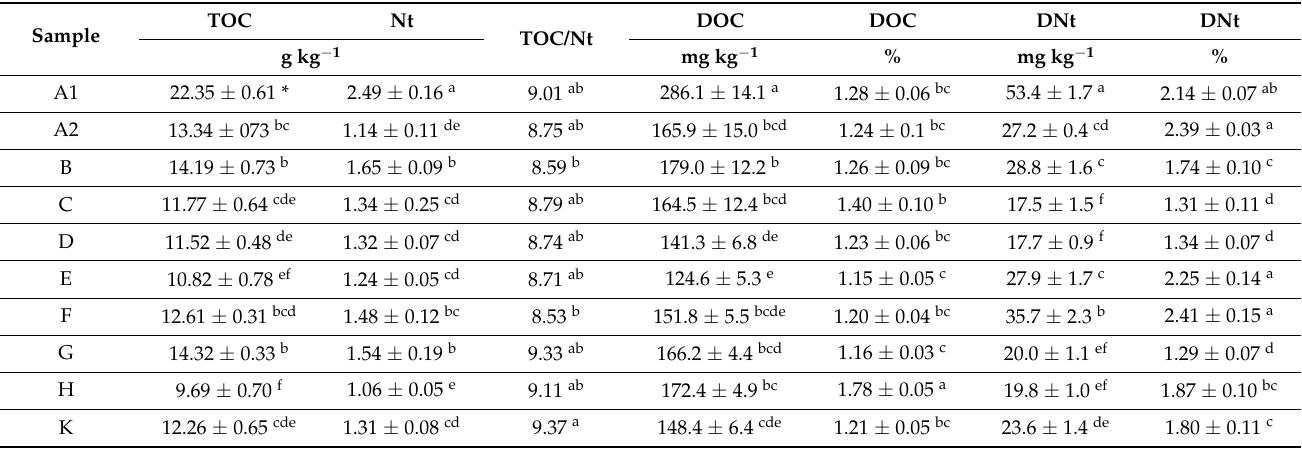
Table 2. Content of total organic carbon (TOC) and total nitrogen (Nt) and content and share of dissolved organic carbon (DOC) and nitrogen (DNt).